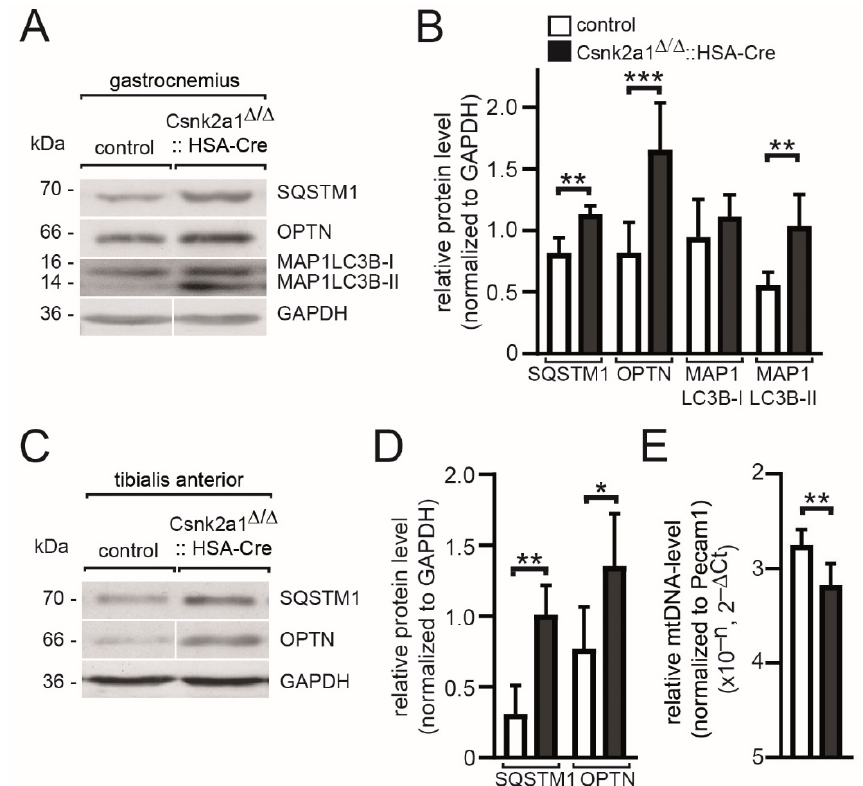
Figure 6. Autophagy is impaired in conditional Csnk2a1 knockout mice. ( A ) Gastrocnemius muscle lysates were used for SDS-PAGE and Western blot; membranes were probed with antibodies labeling proteins implicated in autophagy, namely MAP1LC3B-I/II, SQSTM1, OPTN, and for normalization, GAPDH. ( B ) Graph summarizes quantification of protein bands as seen in ( A ) using Fiji. ( C ) Similar to in ( A ) with muscle lysates of tibialis anterior. ( D ) Graph quantitates protein amounts as shown in ( C ). ( E ) Graph shows the result of qPCR approach to compare the amount of mitochondrial DNA between conditional Csnk2a1 knockout and control tibialis anterior and extensor digitorum longus muscle. Note, the increased amount of MAP1-LC3BII, SQSTM1, and OPTN refers to impaired mitophagy. All labeling of graph bars represents the genotype of mice as indicated in ( B ). Data are represented as mean ± S.D.; n ≥ 5 mice per genotype. *** p < 0.001, ** p < 0.01, * p < 0.05.